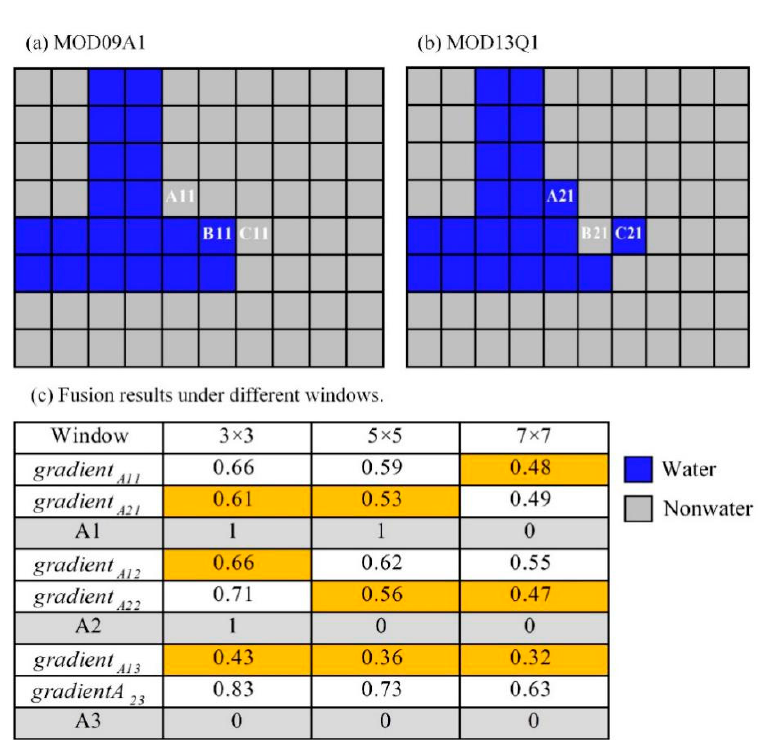
Figure 6. An illustrative example showing the fusion results under different windows when both the period and the value of the two results are inconsistent. ( a ) The schematic of MOD09A1; ( b ) the schematic of MOD13Q1; and ( c ) fusion results under different windows.